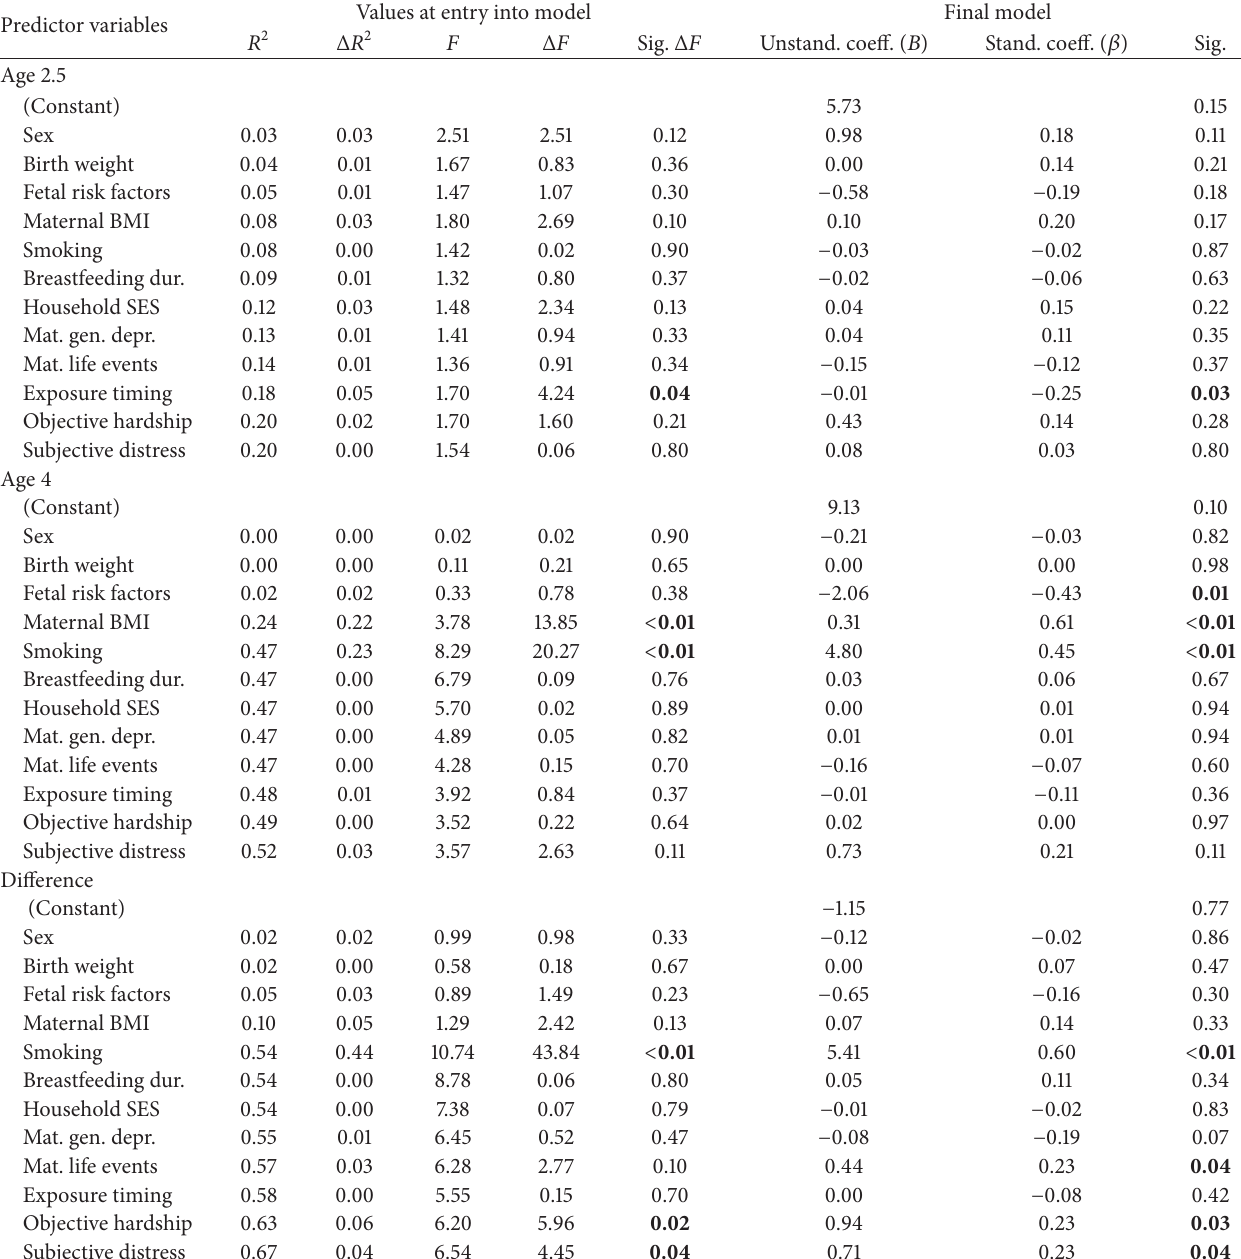
Table 3: Summary of hierarchical linear regression analyses for total adiposity (SS + TR). Significant effects are indicated in bold. Predictor